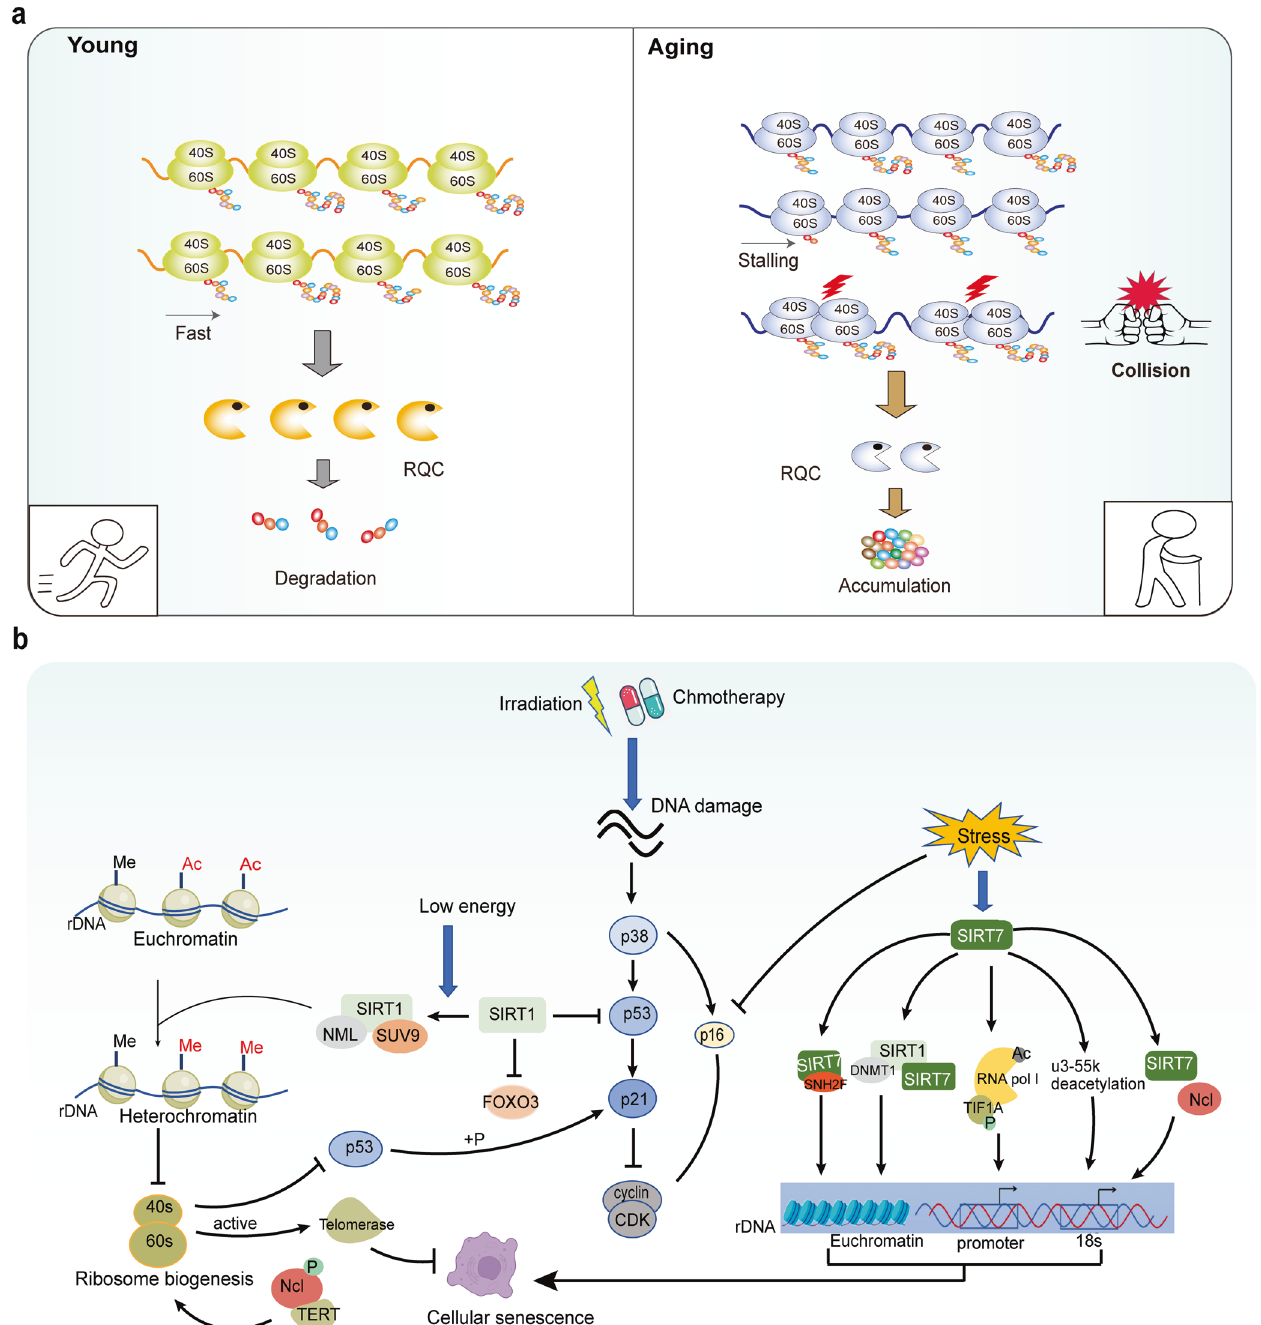
Fig. 7 a Ribosome-stalling/collision/ribosome dysfunction and aging. The primary clearance pathway for ribosome collisions is the degradation of nascent peptides through ribosomal quality control (RQC). RQC decreases with age, and ribosome-stalling/collision triggers ribosome dysfunction. As a result, ribosome dysfunction leads to increased nascent polypeptides and protein aggregation. b Ribosomes and the signaling pathway of cellular senescence. Cellular DNA damage can be induced by radiation or chemotherapy, which activates p53- dependent stress responses and cause cellular senescence. SIRT1, a member of the longevity protein family, directly affects the activity of key proteins in the senescence pathway through deacetylating transcription factors. Moreover, SIRT1 recruits methylation enzymes to affect ribosome biogenesis by regulating chromatin remodeling, and abnormal ribosome biogenesis can directly affect p53 and telomerase activity to accelerate cellular senescence. Genomic instability of rDNA causes cellular senescence, and SIRT7, a member of the longevity protein family, affects rDNA stability by interacting with chromatin remodeling factors and RNA polymerase. Ncl and SIRT7 interact with proteins, and Ncl binding to telomeric reverse transcriptase affects ribosome biogenesis. Ac acetylation, CDK cyclin-dependent kinases, Me methylation, Ncl nucleolin, p phosphorylation, rDNA ribosomal DNA, RNA pol Ι RNA polymerase Ι